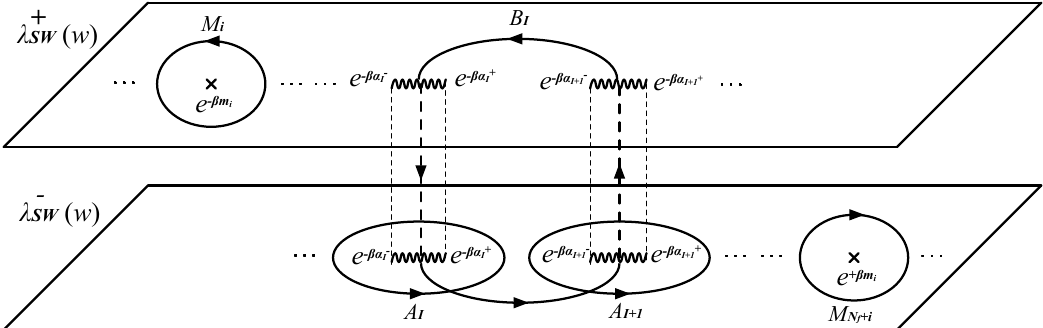
( w ) is defined on the lower complex SW